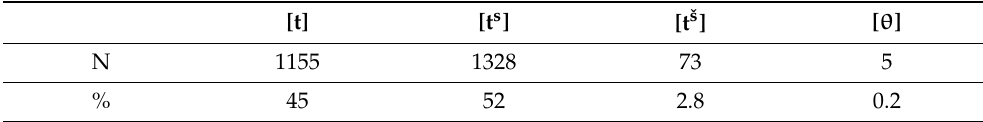
Table 2. Dental variants